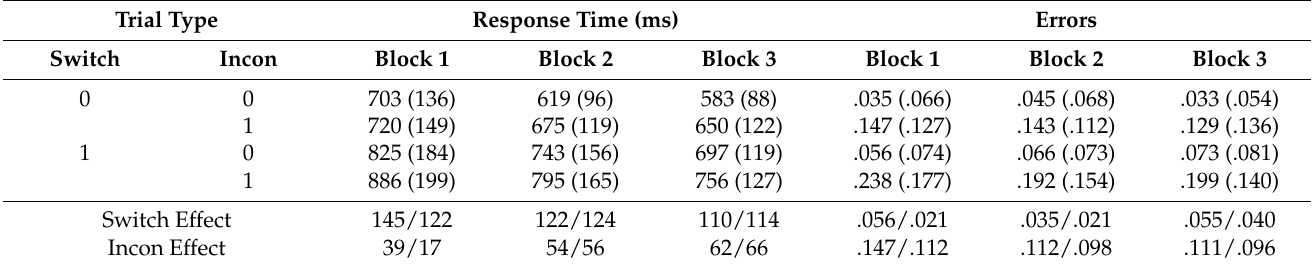
Table 1. Mean (SD) for the observed performance